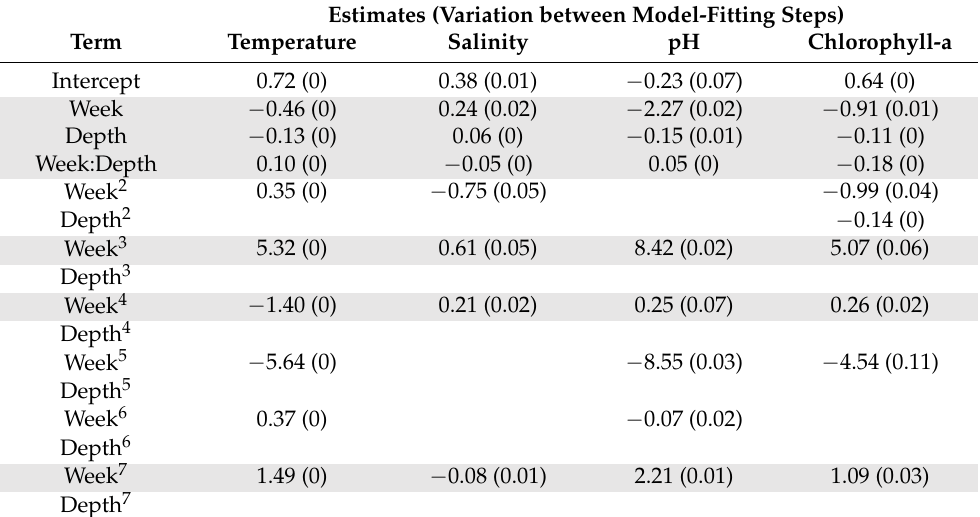
Table 3. Observation-level terms included in the best-performing observation-level and multilevel models, and their estimates based on the multilevel random slope models. In addition, the variation of the estimates between model-fitting steps are reported in the brackets. This is the difference between largest and smallest estimates at the predictor variable’s scale, considering the best observation-level, intercept-only and random slope models. Note that the model selection was repeated at each step of the modelling process, but the term selection was identical at each step. Common terms across all four models are highlighted with grey